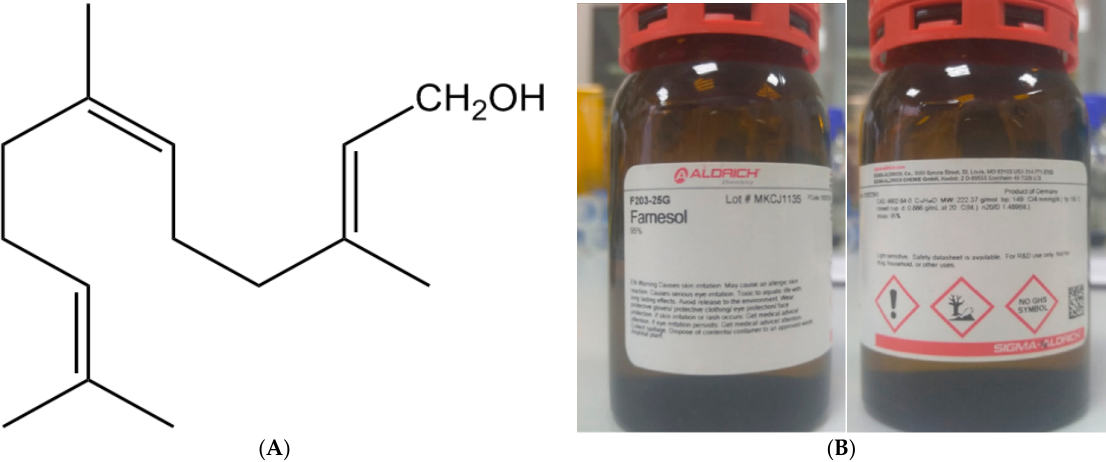
Figure 2. ( А ) the chemical formula of Farnesol; ( B ) the appearance of the drug Farnesol (Far) (Sigma- Aldrich, Darmstadt, Germany).